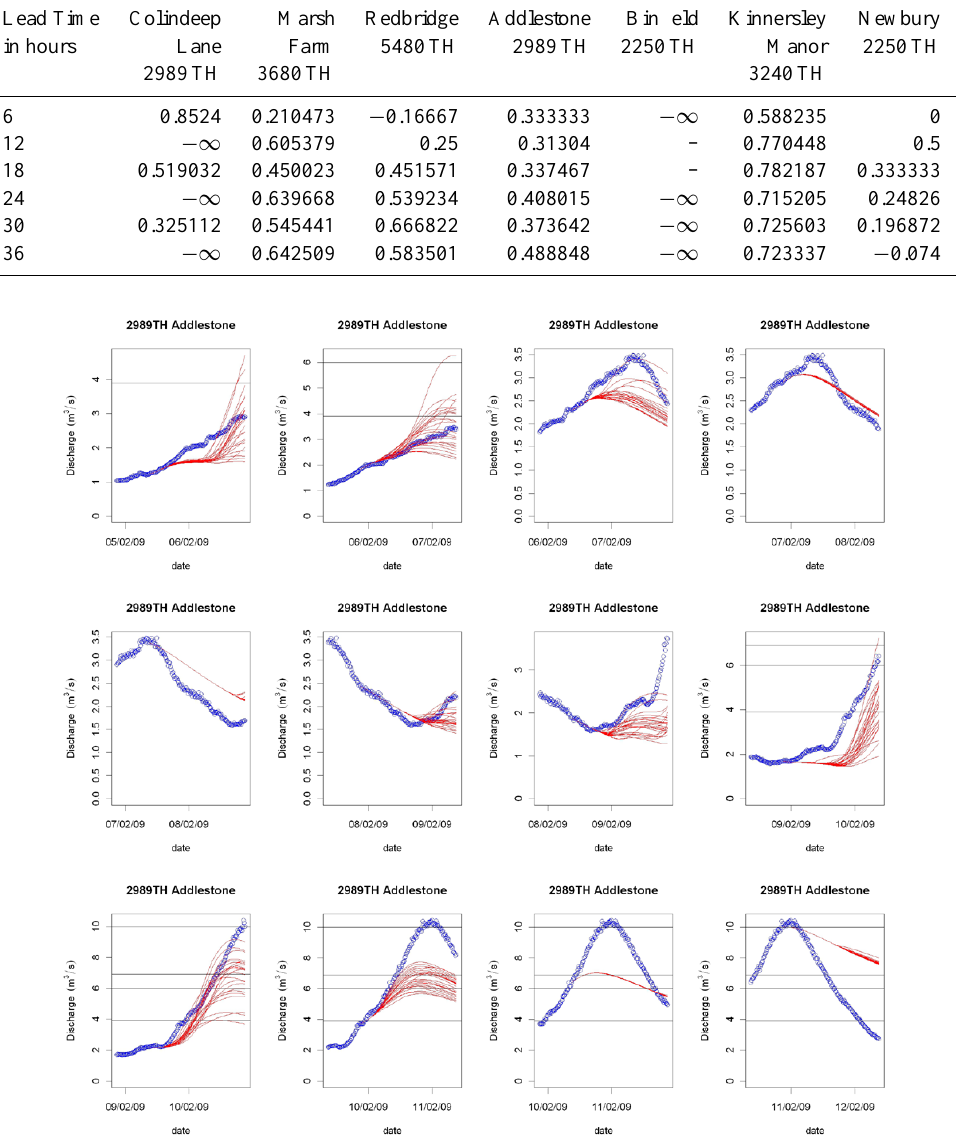
Fig. 4. Flow forecast ensembles for 12 consecutive forecasts, 12h apart, in February 2009 at Addlestone. Observed flows indicated by circles. Horizontal lines represent the thresholds from Table